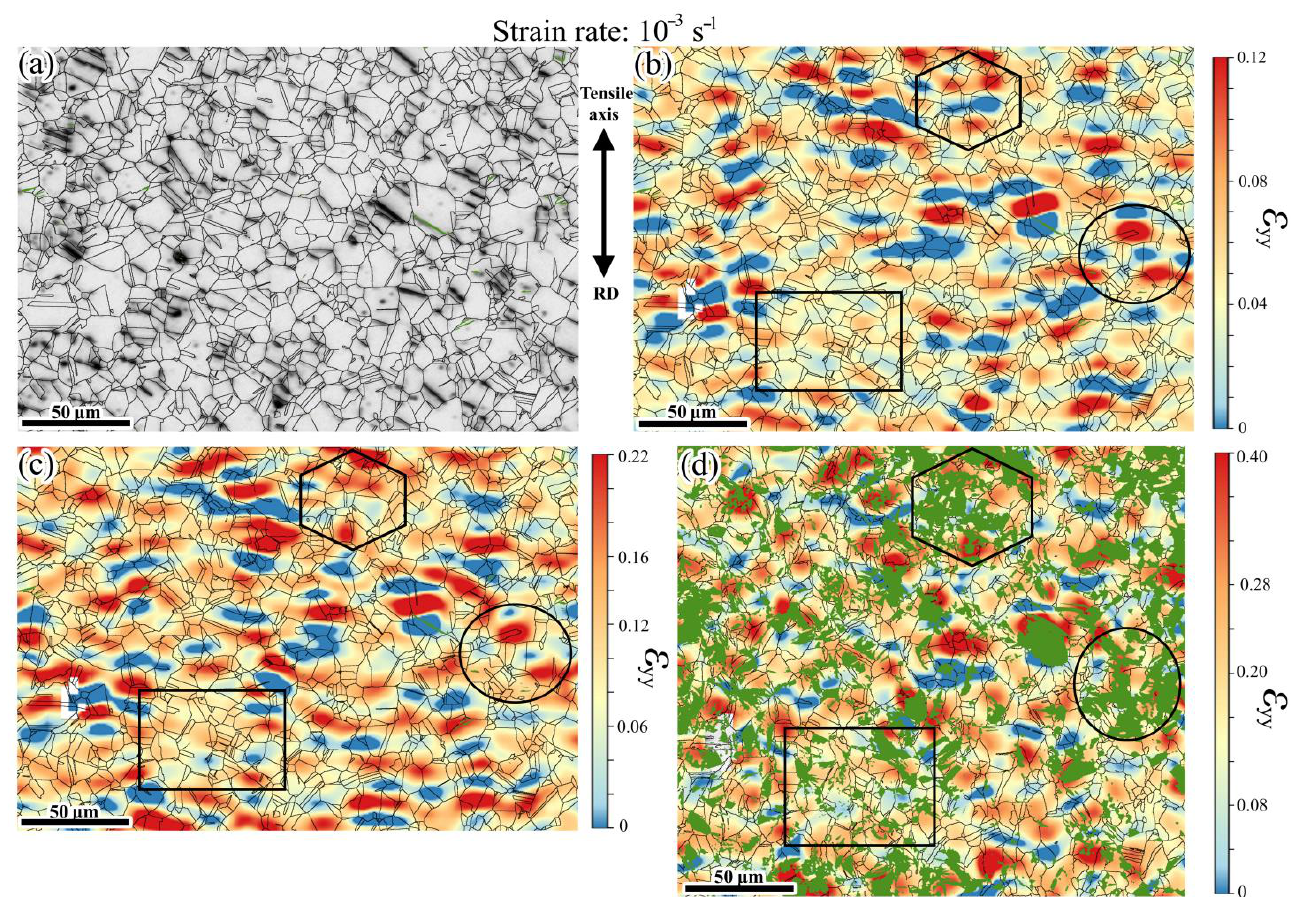
Figure 4. ( a ) Undeformed microstructure, and µDIC maps overlaid with EBSD data of the specimen deformed to global strains of ( b ) ε pl = 0.057, ( c ) ε pl = 0.112, and ( d ) ε pl = 0.2 at the strain rate of 10 −3 s −1 . The color coding represents the microscopic strain distribution, the black lines represent the grain boundaries, and the green color in ( d ) represents the transformed α’ -martensite particles after de- formation. The markings provided with different symbols in the Figure correspond to the same regions of the microstructure at various macroscopic strain levels. Additional information can be found in the text.